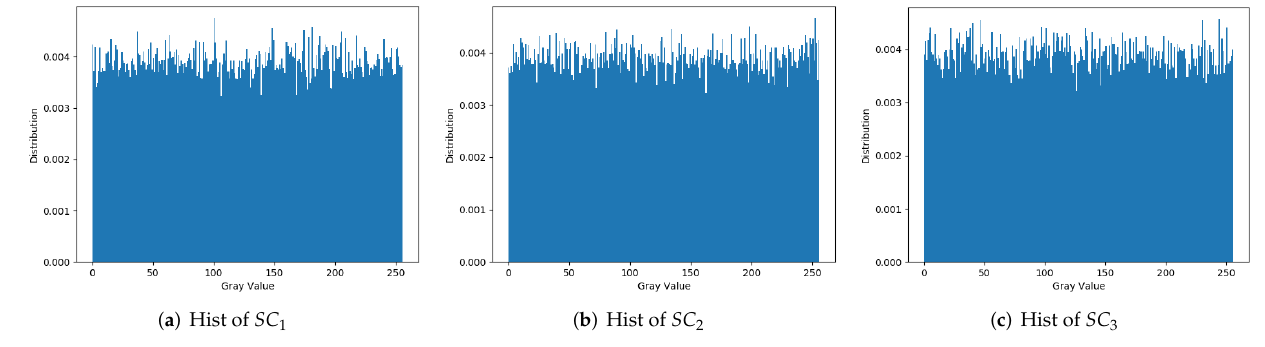
Figure 3. Histograms of the shares in Figure